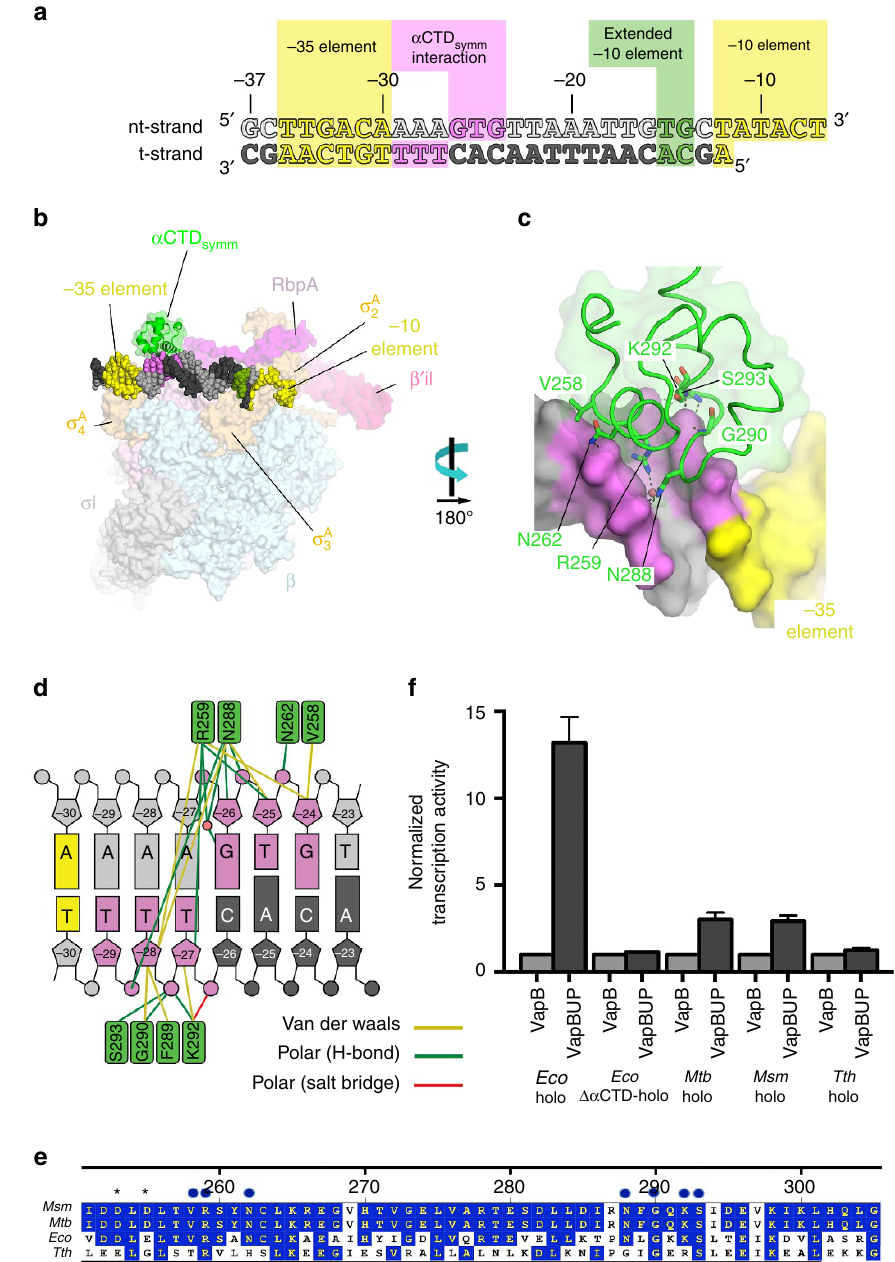
Figure 3 | Mycobacteria a CTD/DNA interactions. ( a ) Sequence of the us-fork promoter fragment used in the 2.76Å-resolution Msm TIC structure 4 . The numbers above denote the DNA position with respect to the transcription start site ( þ 1). The DNA sequence is derived from the full con promoter 63 . The nt-strand DNA (top strand) is coloured light grey; the t-strand DNA (bottom strand), dark grey. The (cid:2) 35 and (cid:2) 10 elements are shaded yellow. The extended (cid:2) 10 (ref. 38) is coloured green. The DNA nts interacting with a symmetry-related a CTD ( a CTD symm ) are coloured violet. ( b ) Overall view of the Msm RbpA/E s A /us-fork complex. The color-coding is the same as Fig. 1b. The RNAP is shown as a molecular surface. The DNA is shown in CPK format, color-coded as Fig. 2a. Also shown is a CTD symm (green backbone ribbon with transparent green molecular surface). ( c ) Close-up of a CTD symm /DNA interactions (viewed from the back side of Fig. 2b). The a CTD symm is shown as a green backbone worm with conserved DNA-interacting side chains shown (polar interactions are shown as grey dashed lines). A well-ordered water molecule mediating a CTD symm interactions is shown as a pink sphere. The DNA is shown as a molecular surface. ( d ) Schematic illustrating a CTD symm /DNA interactions. ( e ) Sequence alignment of Msm , Mtb , Eco and Tth a CTDs. The numbering at the top denotes the Msm and Mtb numbering. Residues conserved in at least three of the seqences are shaded blue. Residues that interact with the DNA are denoted with blue dots above the sequences. The DNA-interacting residues are all conserved between Msm , Mtb , and Eco , but not with Tth. Negatively charged residues shown to be important for Eco a CTD/ s 70 4 interactions that play a role in stimulating transcription are are denoted with asterisks (*) above. We infer that these residues also play a role in stimulatory Msm and Mtb a CTD/ s A 4 interactions as well since they are conserved as negatively charged residues in Msm and Mtb . ( f ) Histogram showing abortive transcription activity of various holoenzymes (shown below) on the Mtb VapB promoter (normalized to 1) and VapBUP (engineered to contain a proximal UP-element sequence (Supplementary Fig. 6B,C). The values are the average of triplicate experiments. The error bars denote the